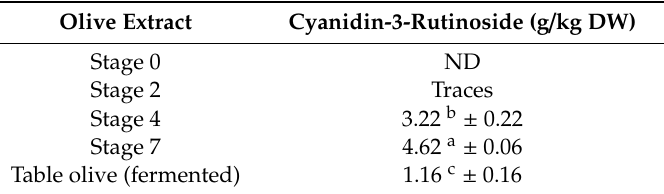
Table 2. Anthocyanin contents in Cellina di Nard ò olive extracts during maturation stages and after fermentation. Data are reported as g / kg DW of cyanidin 3-rutinoside. Same letters indicate no statistical di ff erences between averages (Duncan test, n = 3, p = 0.05).